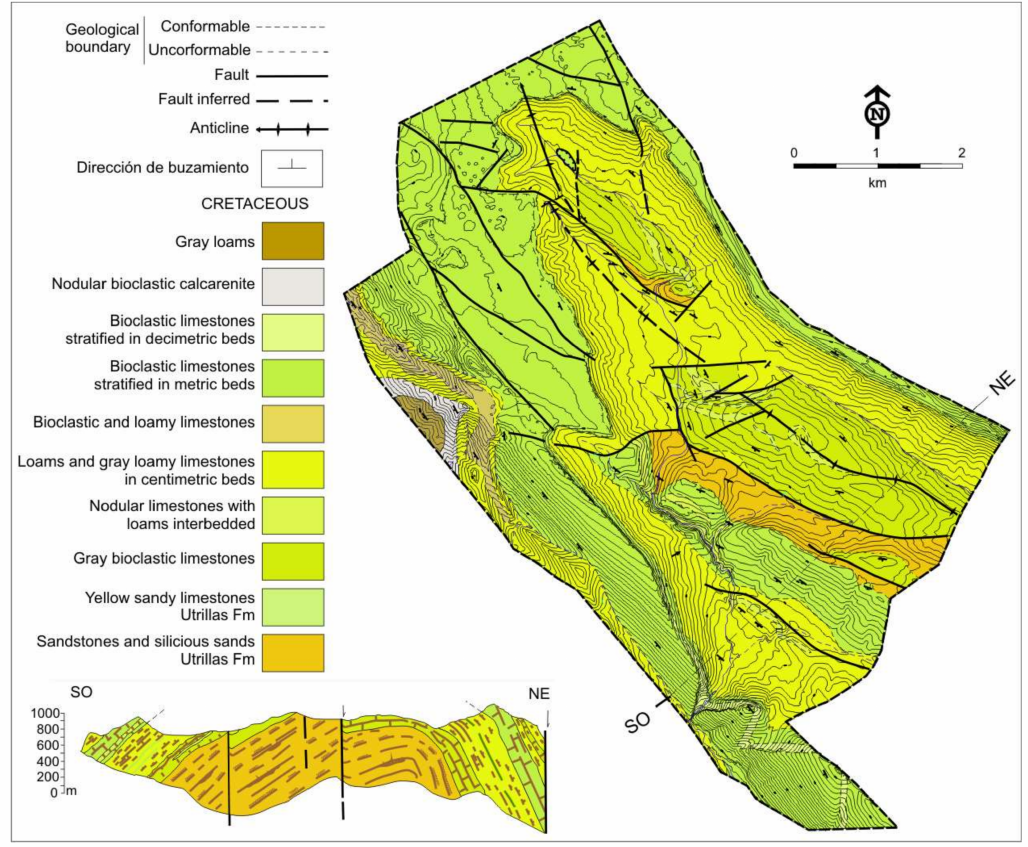
Figure 4. Valderejo Natural Park. Geological